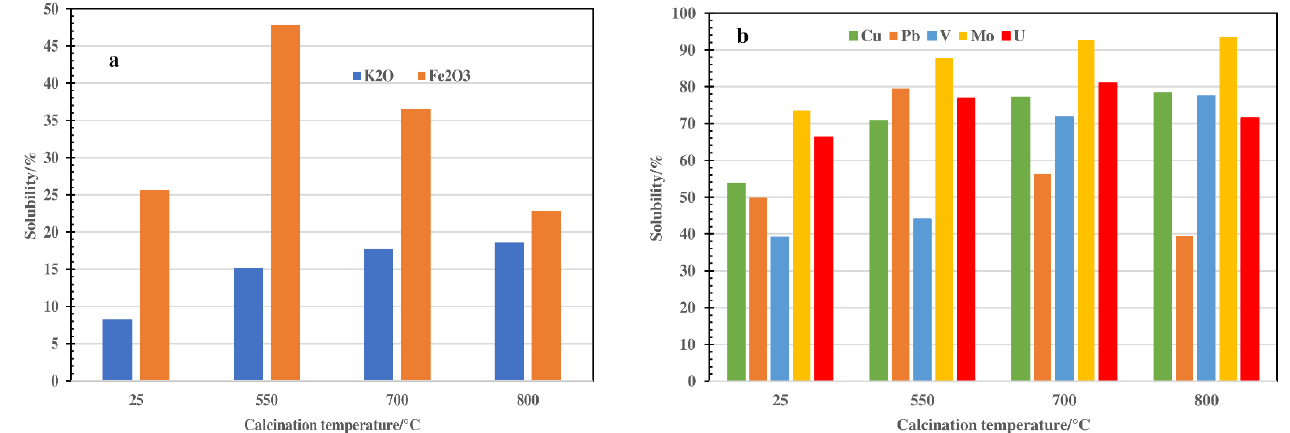
Figure 9. Solubility of components (relative %) at treatment of Toolse GA sample with 10% H 2 SO 4 solution (90 °C, 3h): ( a ) K 2 O and Fe 2 O 3 , ( b ) Cu, Pb, V, Mo, and U.